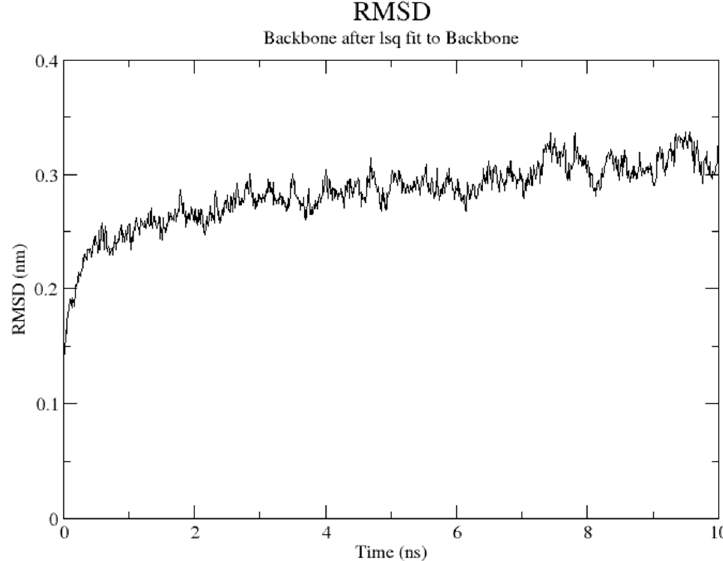
Figure 7. Total root-mean square deviation (RMSD) evolution along simulation time.